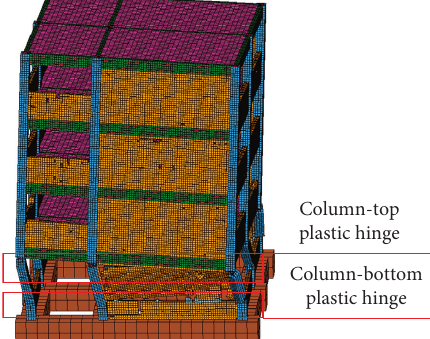
Figure 37: First-floor failure state of the simulation (right).